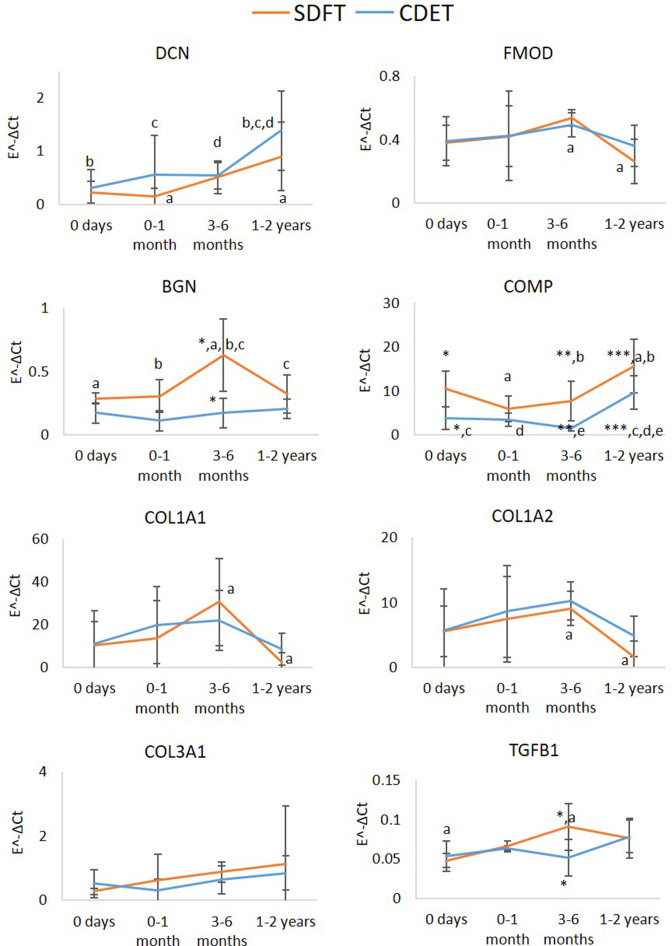
Relative mRNA expression of major ECM genes in whole tissue SDFT and CDET through postnatal development.* Significant difference between tendons, a-e significant difference between age groups. Error bars depict standard deviation.